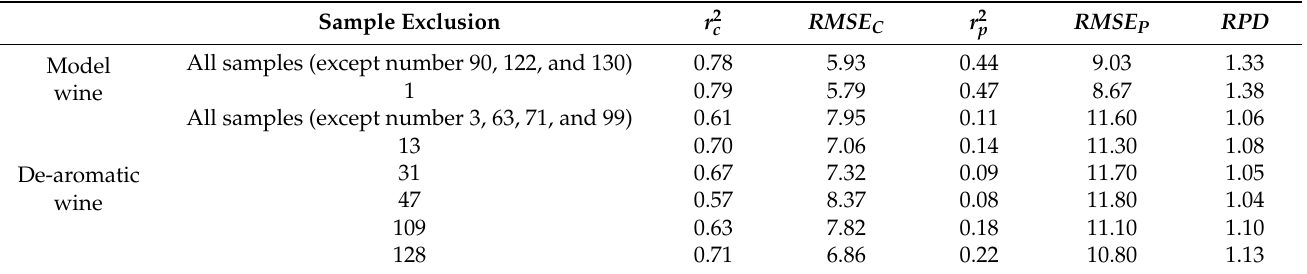
Figure 3. The outlier analysis by the Hotelling T 2 statistics in the coordinate of PCA. ( a ) The model wines; ( b ) the de-aromatic wines. Table 2. Results of model validation after outlier rejection between 95% and 99% confidence space.